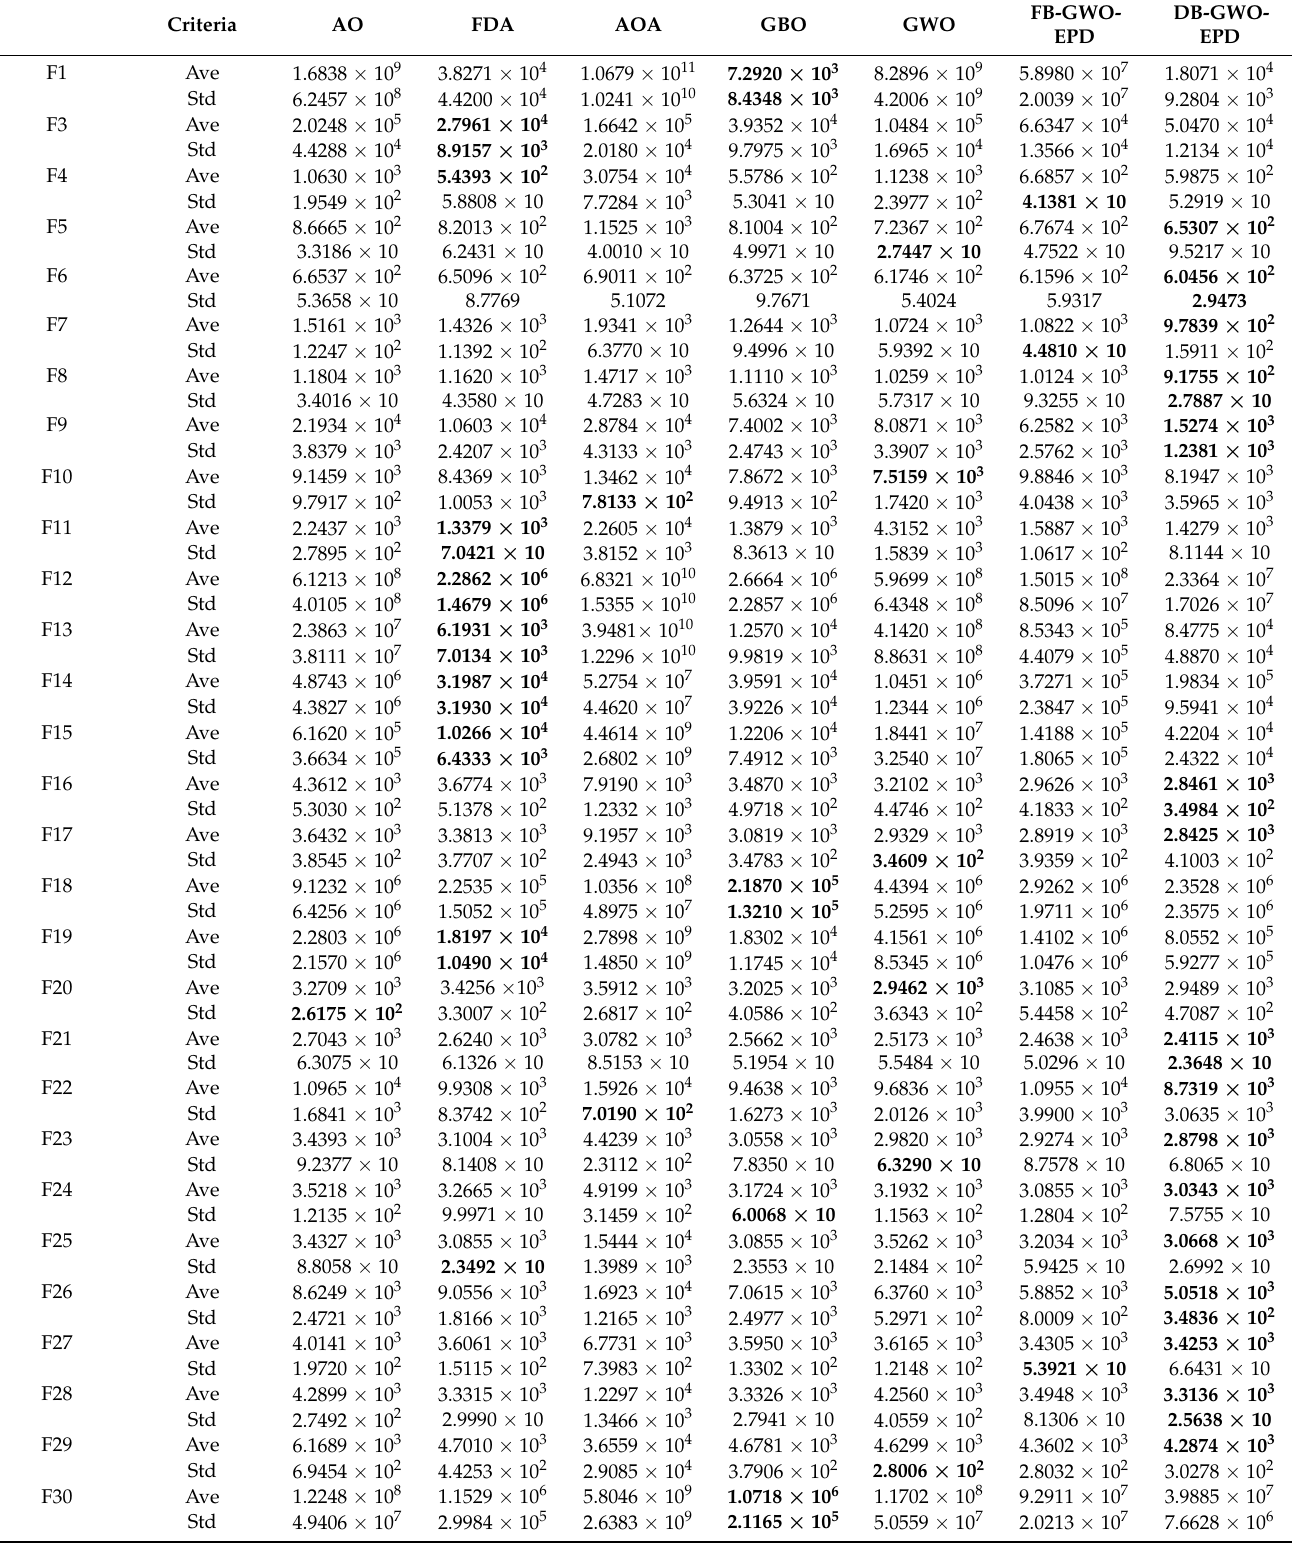
Table 6. Results of the DB-GWO-EPD and its rivals on the 50-dimensional CEC2017 test